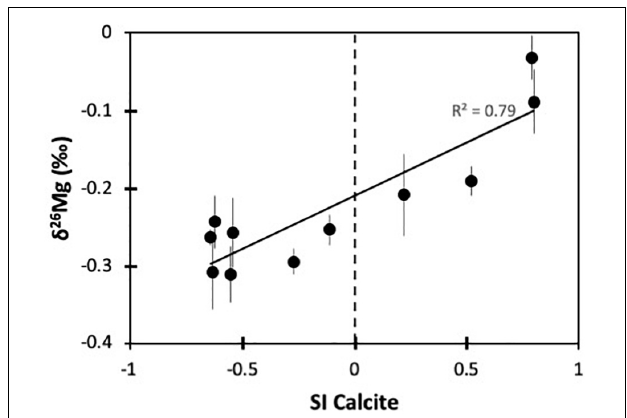
FIGURE 10 | Mg isotope ratios in the Laxa River outflow time series as a function of the saturation index of